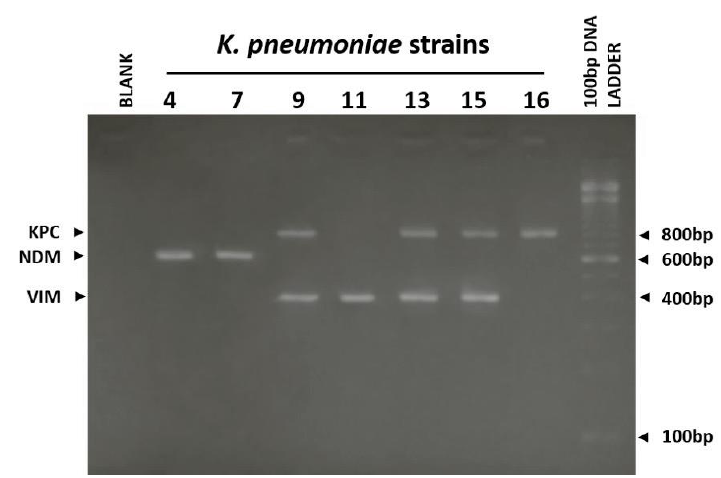
Figure 1. Agarose gel electrophoresis (2% w/v ) used for the separation of PCR products produced by a multiplex PCR reaction against bla KPC , bla NDM , bla OXA-48 and bla VIM genes. Blank corresponds